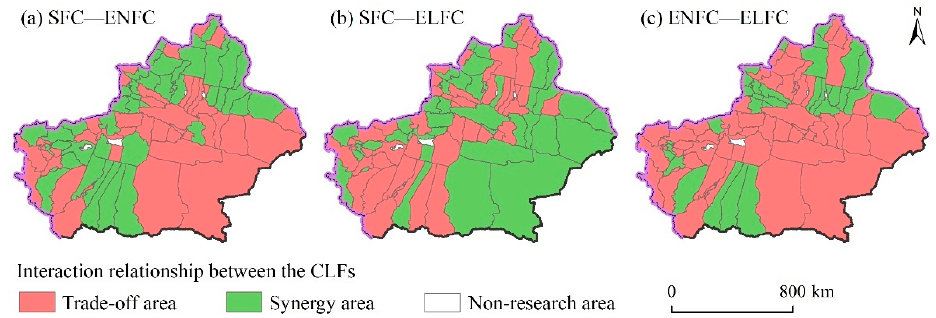
Figure 7. Pattern of interaction between CLFs at the county level in Xinjiang: ( a ) The interaction between SFC and ENFC; ( b ) The interaction between SFC and ELFC; and ( c ) The interaction between ENFC and ELFC.